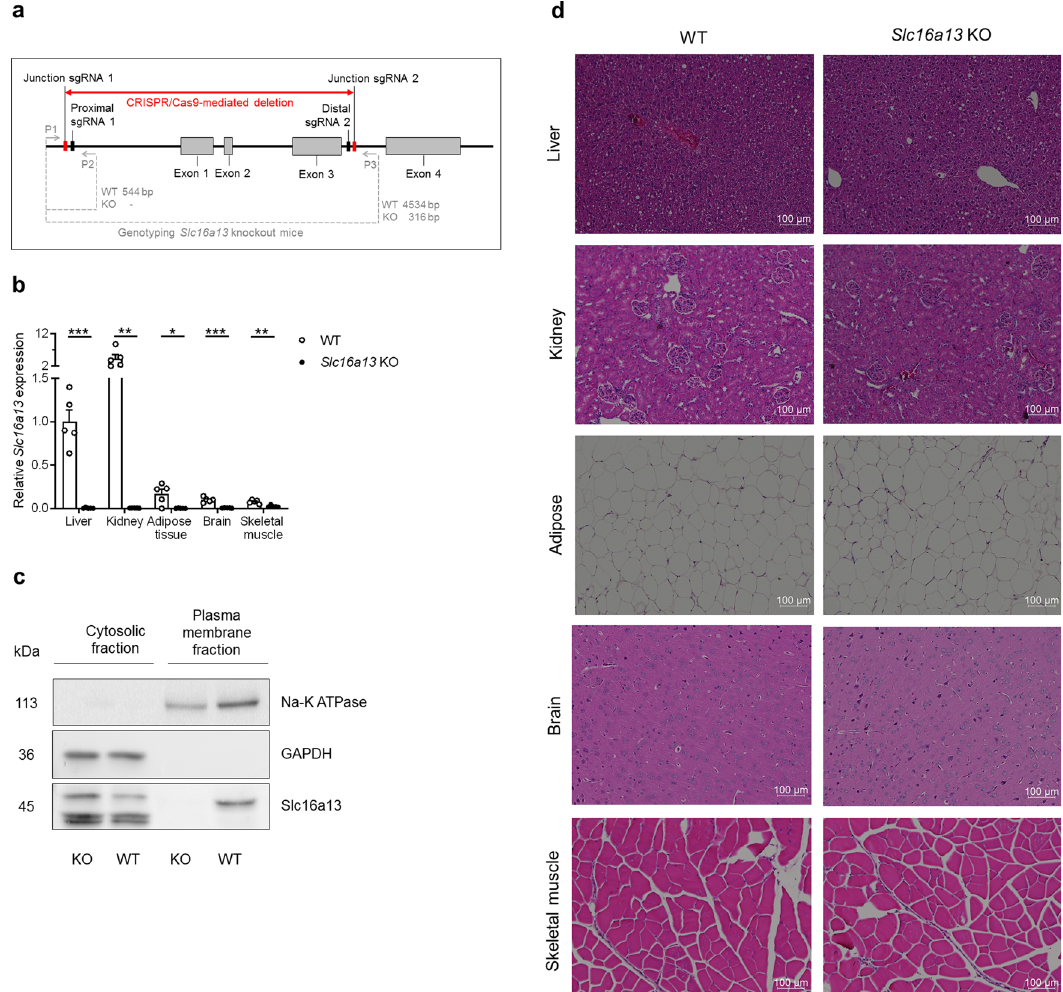
Fig. 3 Generation of Slc16a13 knockout mice using CRISPR/Cas9 technology. a Deletion of 4.2 kb including 1.8 kb of the proximal promotor region, exon 1, exon 2, and exon 3 of the mouse Slc16a13 gene as indicated by the red arrow. To distinguish between the wild-type (WT) and Slc16a13 knockout (KO) allele on the DNA level, a forward primer (P1) binding upstream of junction 1 is used in combination with the two reverse primer P2 binding within and P3 binding downstream the deleted region as indicated by the gray arrows. mRNA expression levels in WT and KO tissue are analyzed by qRT-PCR primer binding at the exon-exon junctions of exon 1/2 and exon 2/3 (not displayed in the fi gure). b Slc16a13 mRNA expression in different organs of Slc16a13 KO mice relative to WT ( n = 4 – 5 each group). Relative expression calculated as fold change to the liver. Bars represent means ± SEM. * p < 0.05, ** p < 0.01, *** p < 0.001 determined using two-tailed unpaired Student ’ s t -test. c Western blot analysis of cytosolic and plasma membrane fraction extracted from liver lysates of Slc16a13 KO and WT mice. d Histological comparison of Slc16a13 KO mice and WT controls at a mean age of 20 weeks. Representative H&E stainings of the liver, kidney (cortex), white adipose tissue, brain (cortex), and skeletal muscle (quadriceps) at ×10 magni fi